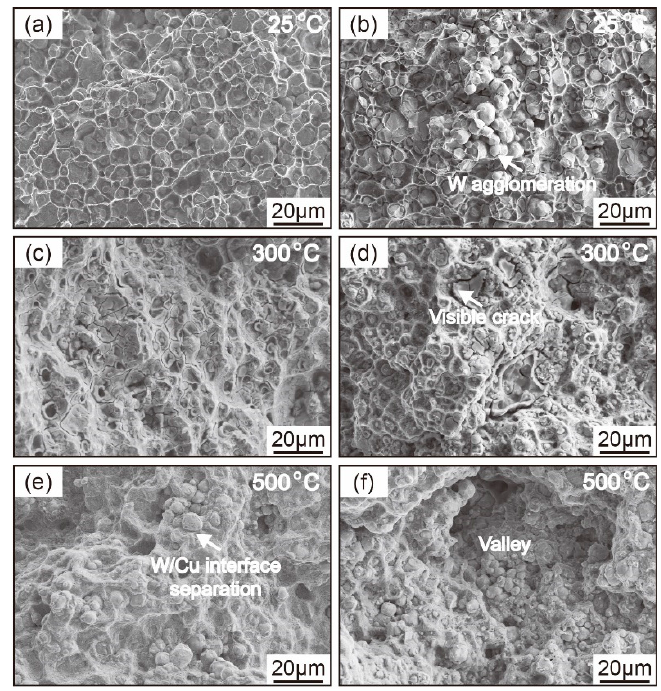
Figure 4. SEM micrographs of the fracture surfaces of W-30Cu composites after tensile testing at different temperatures: ( a ) SCI composite at 25 °C; ( b ) BCI composite at 25 °C; ( c ) SCI composite at 300 °C; ( d ) BCI composite at 300 °C; ( e ) SCI composite at 500 °C; ( f ) BCI composite at 500 °C.